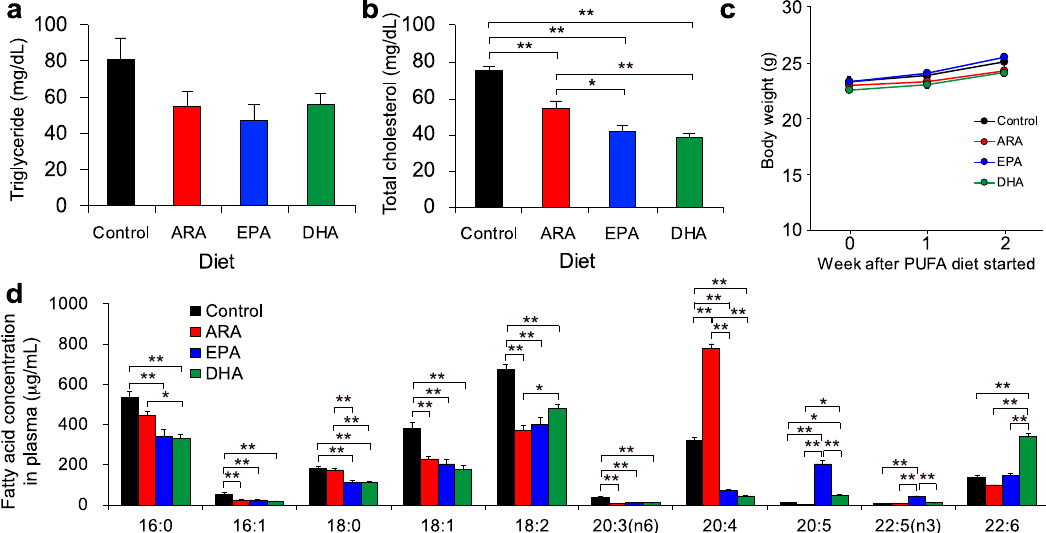
Figure 1. Effects on mouse plasma and body tissues following dietary supplementation with polyunsaturated fatty acids (PUFAs). ( a ) The total triglyceride and ( b ) total cholesterol in plasma were analyzed after two weeks of each PUFA diet. ( c ) The body weight in each PUFA diet condition was traced for two weeks, where the intake was started at 11 weeks of age. ( d ) The concentrations of total fatty acids in plasma were analyzed. The abbreviations ARA, EPA, and DHA, refer to arachidonic acid, eicosapentaenoic acid, and docosahexaenoic acid, respectively. The statistical significance was evaluated by Tukey’s testing (* P < 0.05 and ** P < 0.01) where one-way ANOVA (analysis of variance) showed the statistical significance among groups ( P < 0.05).